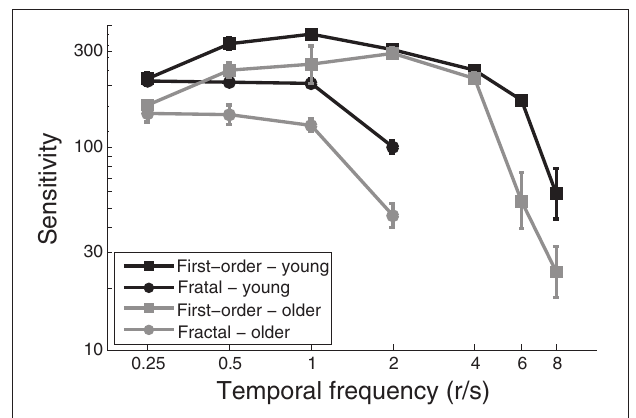
FIGURE 3 | Mean contrast sensitivity to first-order and fractal rotation as a function of temporal frequency. Error bars represent the standard error of the